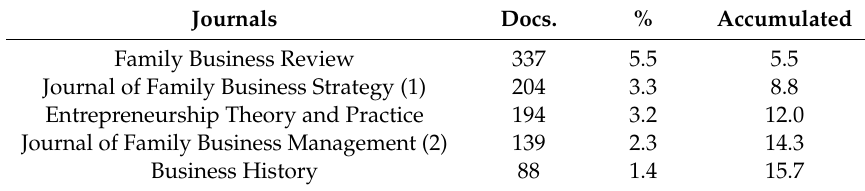
Table 2. Journals on Family Firms.